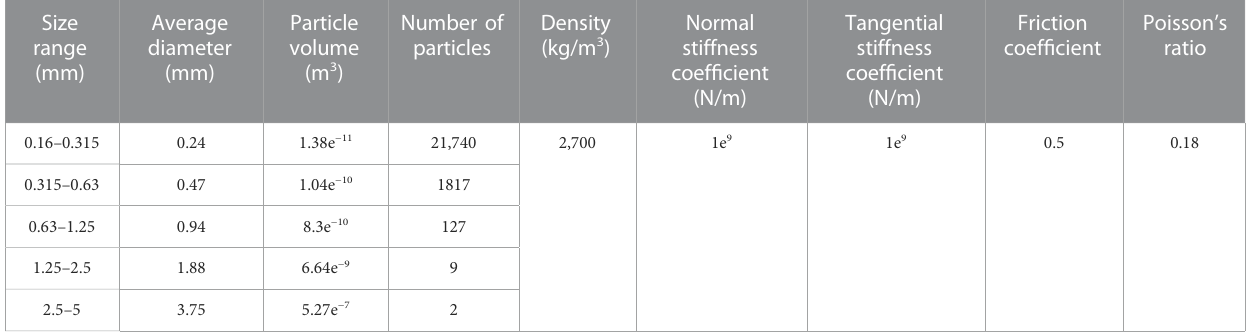
TABLE 9 Number of clogging materials and contact parameters in each particle size